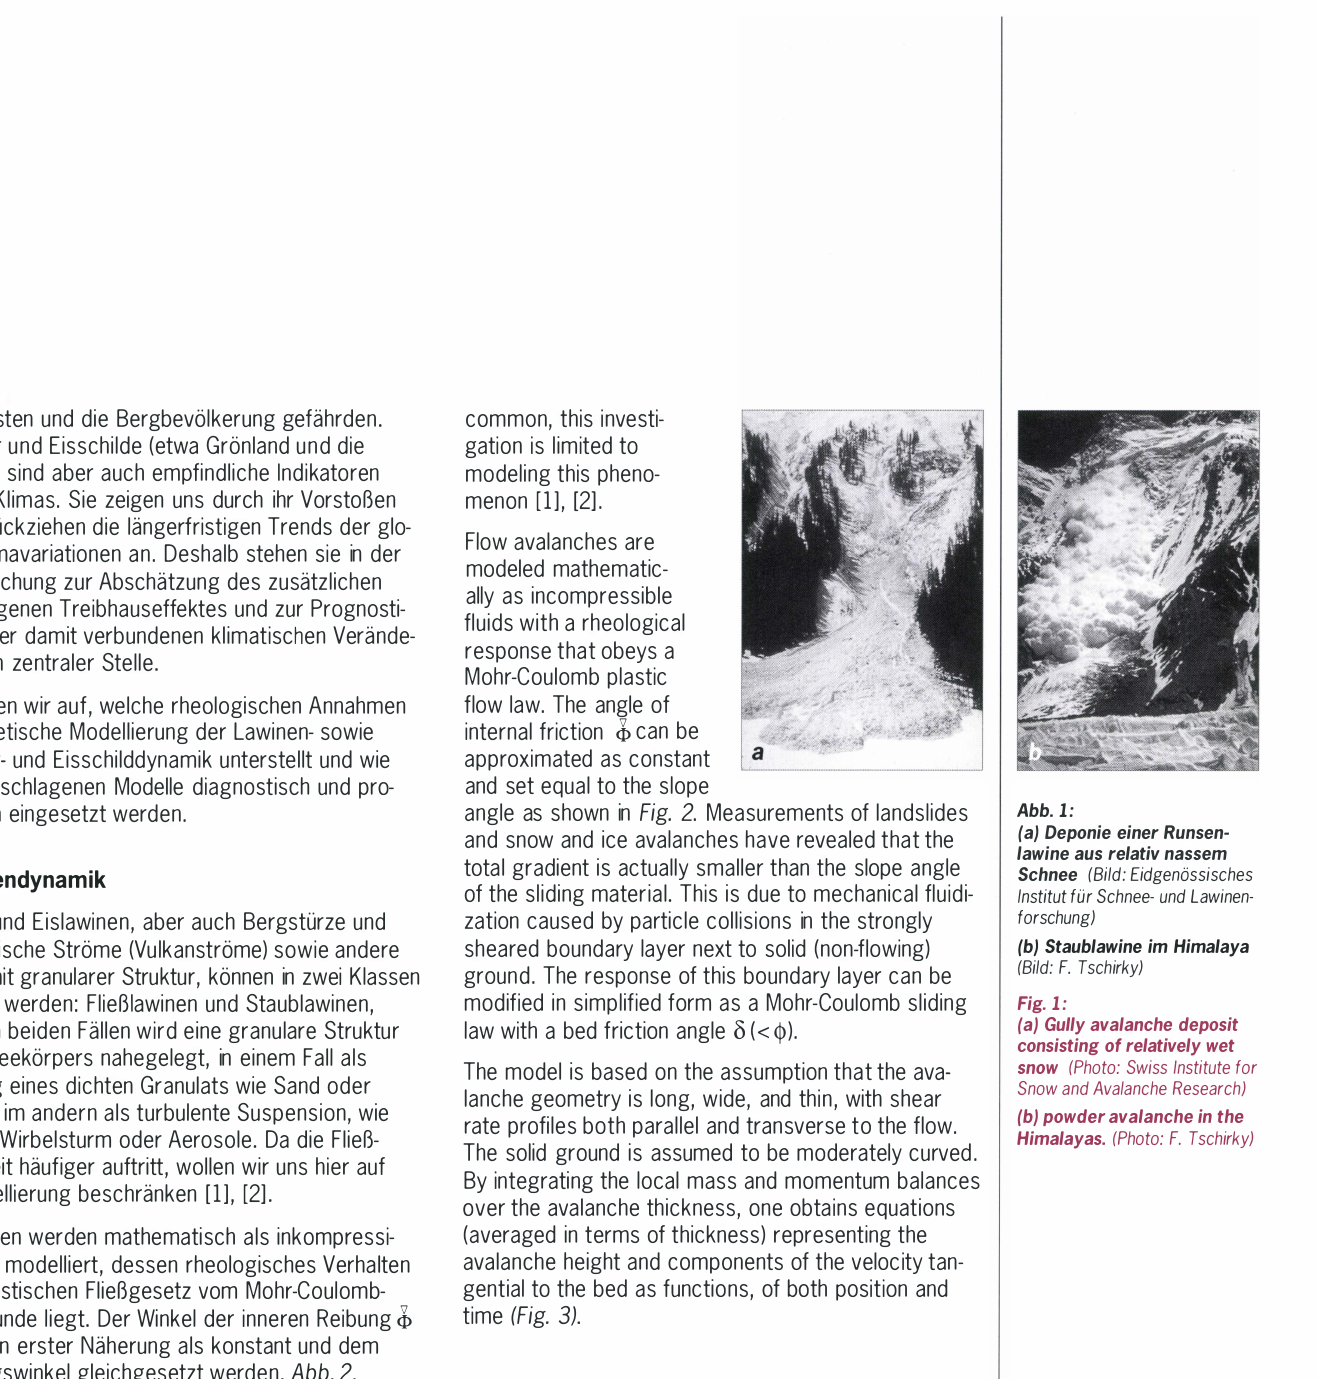
Fig. 2: Definition of "total gradient", slope angle, and Mohr-Coulombic flow criteria of non­ cohesive material (cr = normal pressure; ' = shear stress)